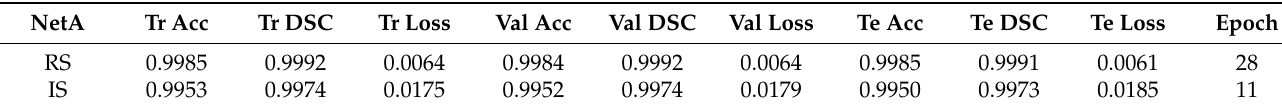
Table 4. Training-related metrics. Abbreviations: NetA—network architecture Tr—training, Te—test, Val—validation, Acc—accuracy.